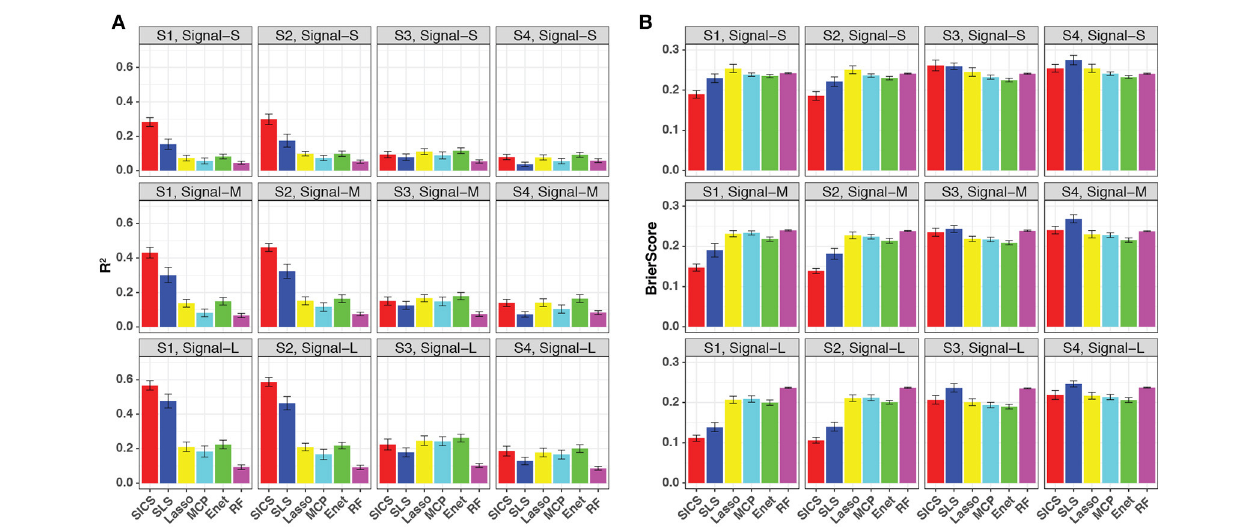
FIGURE 4 | Prediction performance for binary-outcome simulations across different signal levels and scenarios. Both R 2 (A) and Brier score (B) were used for evaluation. S1, S2: phylogeny-informative scenarios, and S3, S4: phylogeny-non-informative scenarios; Signal-S, -M, and -L represent weak, medium and strong signals,